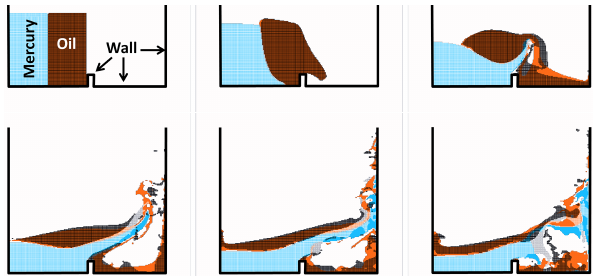
Figure 7. Simulated deposit (view from top in a hillslope debris- flow flume experiment) for a mixture with 28.5% water content and δ = 36 ◦ . The thick solid lines indicate the experimental deposit and vertical thin lines represent the 20cm spacing marks in the experi- mental slope.